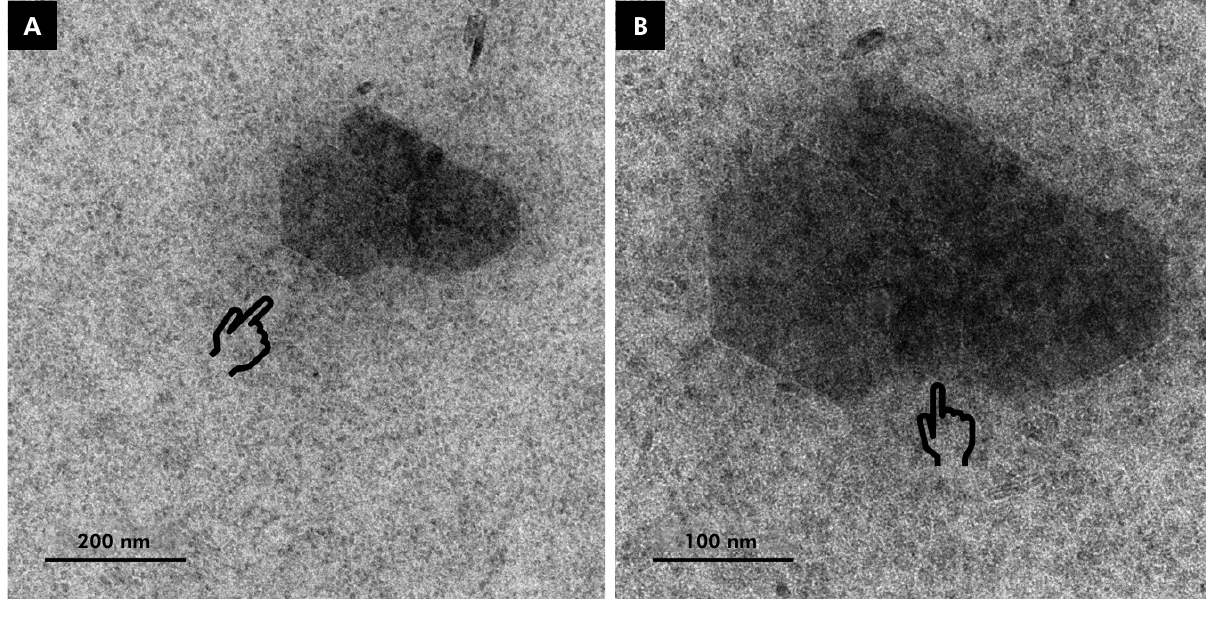
Figure 8. TEM image at of the functionalized UCNPs incorporated into the dental adhesive at (A) 100,000X, and (B) 300,000X magnification. Note the absence of voids indicated by the pointer and the intimate approximation (wetting) of the resin matrix on the surface of the functionalized